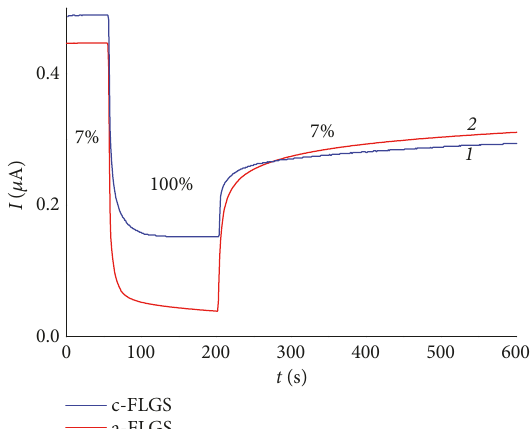
Figure 4: The change in the current in FLGS films at different relative humidity of the environment in which the sample is placed.